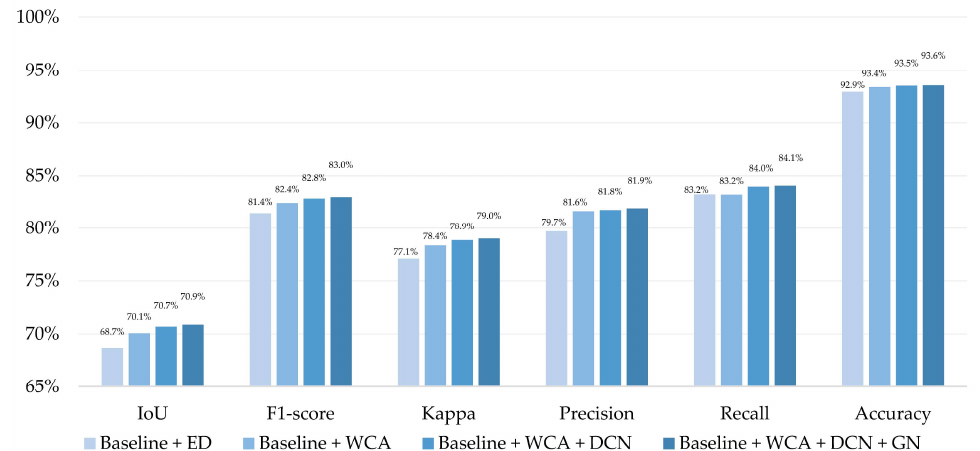
Figure 13. Ablation experimental results obtained on the Massachusetts